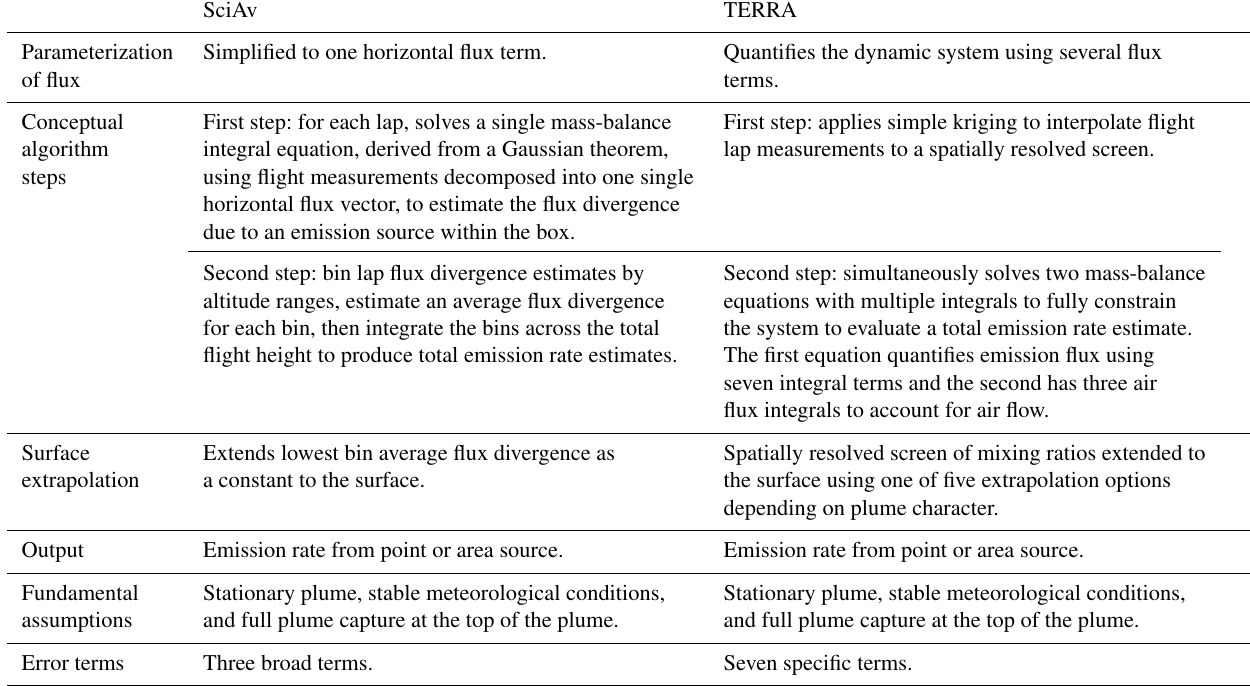
Table 1. Characteristics of the mass-balance SciAv and TERRA algorithm for box-flights. SciAv TERRA Parameterization Simplified to one horizontal flux